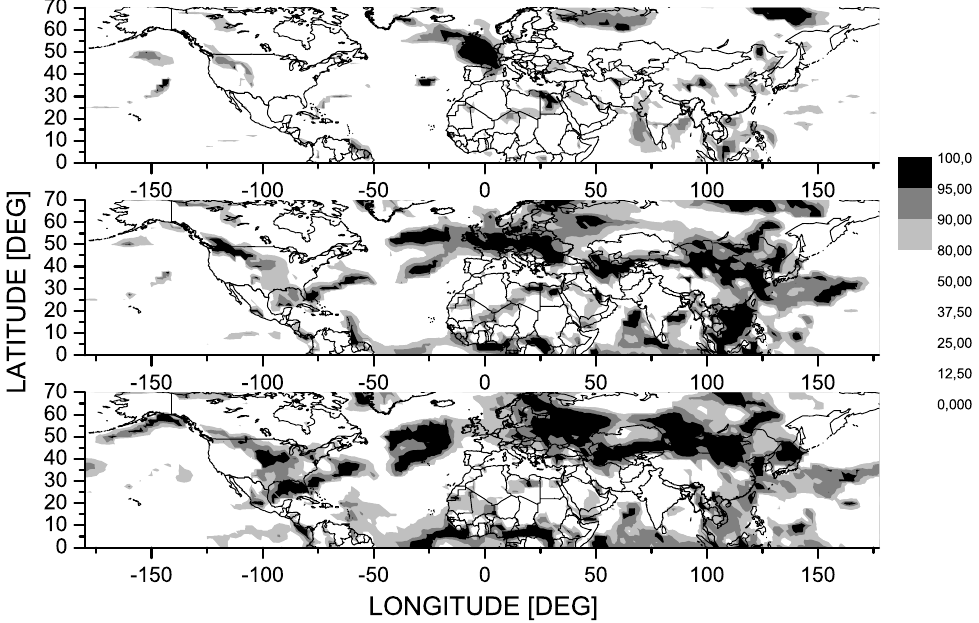
Fig. 4. The significance levels for the mean phase coherence between the sunspot data (top panel), geomagnetic aa index (middle panel), NAO index (bottom panel) and the ERA40 near-surface air temperature for the oscillatory modes obtained using CCWT with the central wavelet period 96 months. The shadowed levels are 80% ( p < 0 . 2, light grey), 90% ( p < 0 . 1, dark grey), and 95% ( p < 0 . 05, black).